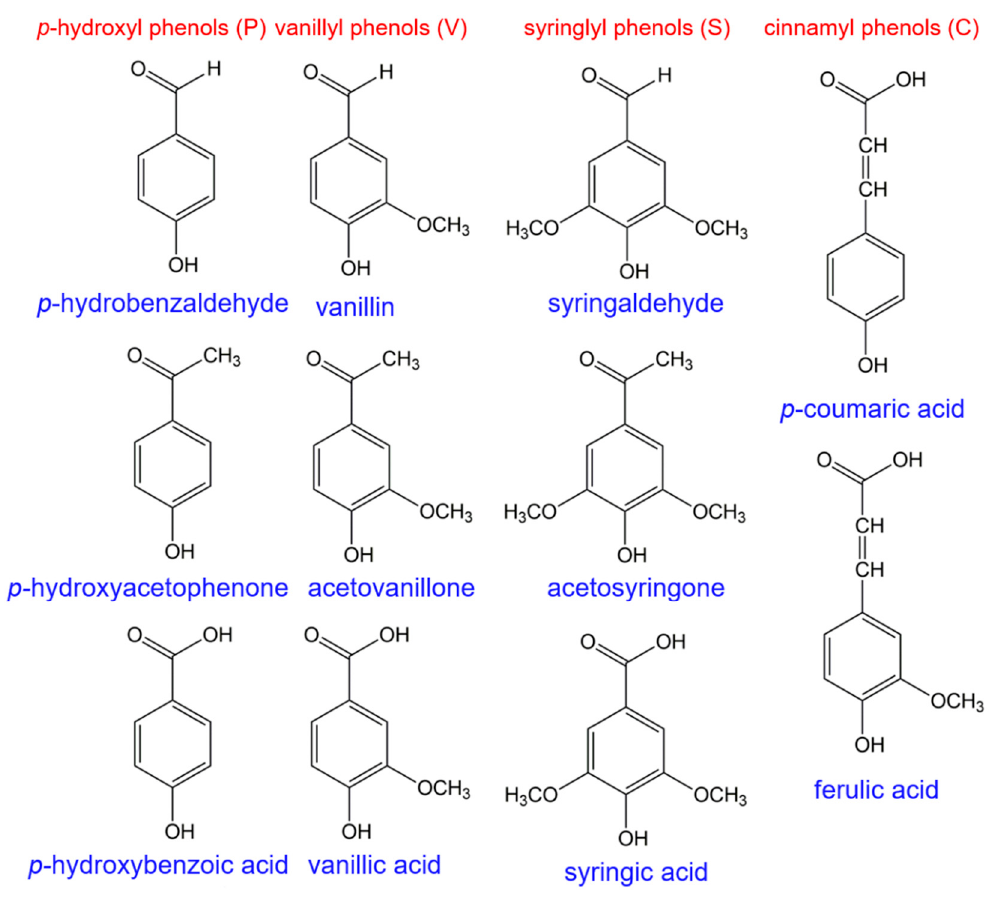
Figure 11. Eleven phenol monomers produced by the CuO oxidation method.